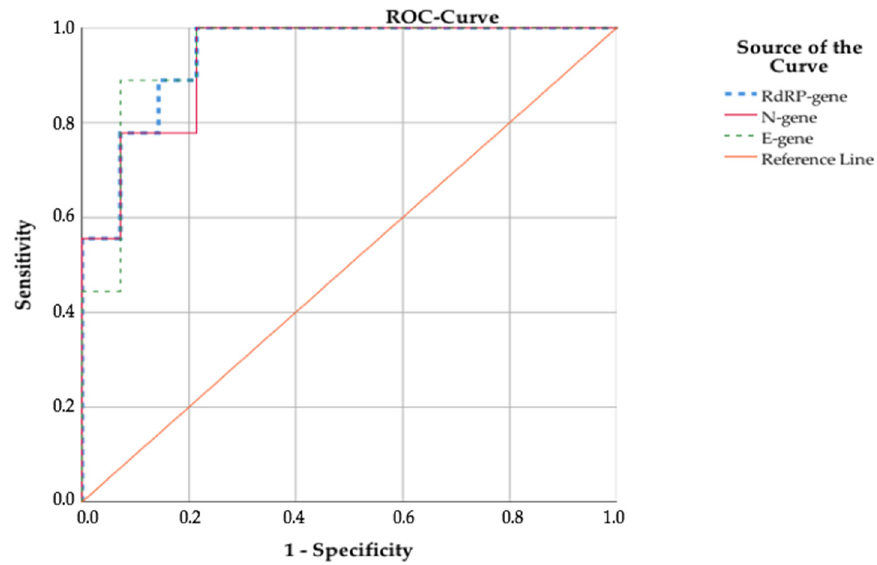
Figure 2. ROC-curves of the different Ct values. In the pediatric group, the Ct cut-off values were <30 (N- and RdRP-gene) and <27 (E- gene) with overall Se and Sp of 100%. For the adult subjects the Ct cut-off values stayed the same with a sensitivity of 100% and specificity of 75% (Appendix A Figure A3). As expected, the total RAT sensitivity was directly dependent on the Ct values (Appendix A Table